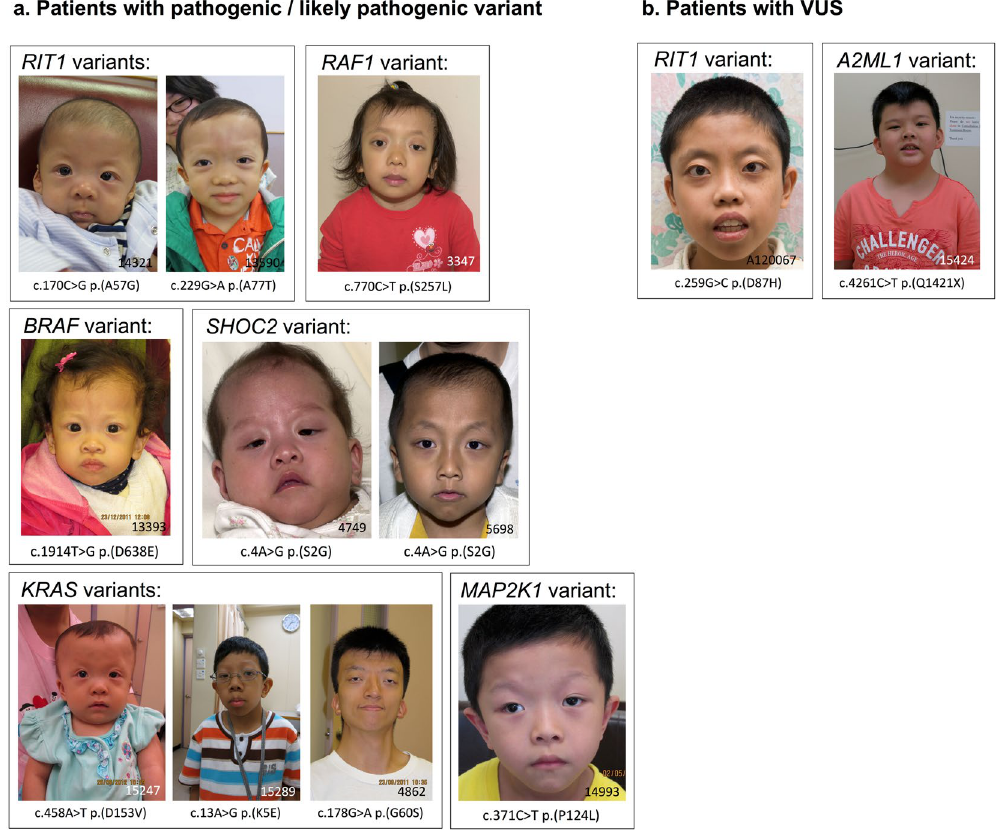
Figure 1. Clinical photographs of patients with variants in genes of the RAS/MAPK signalling pathway. Patients with ( a ) pathogenic or likely pathogenic variants and ( b ) VUSs from our